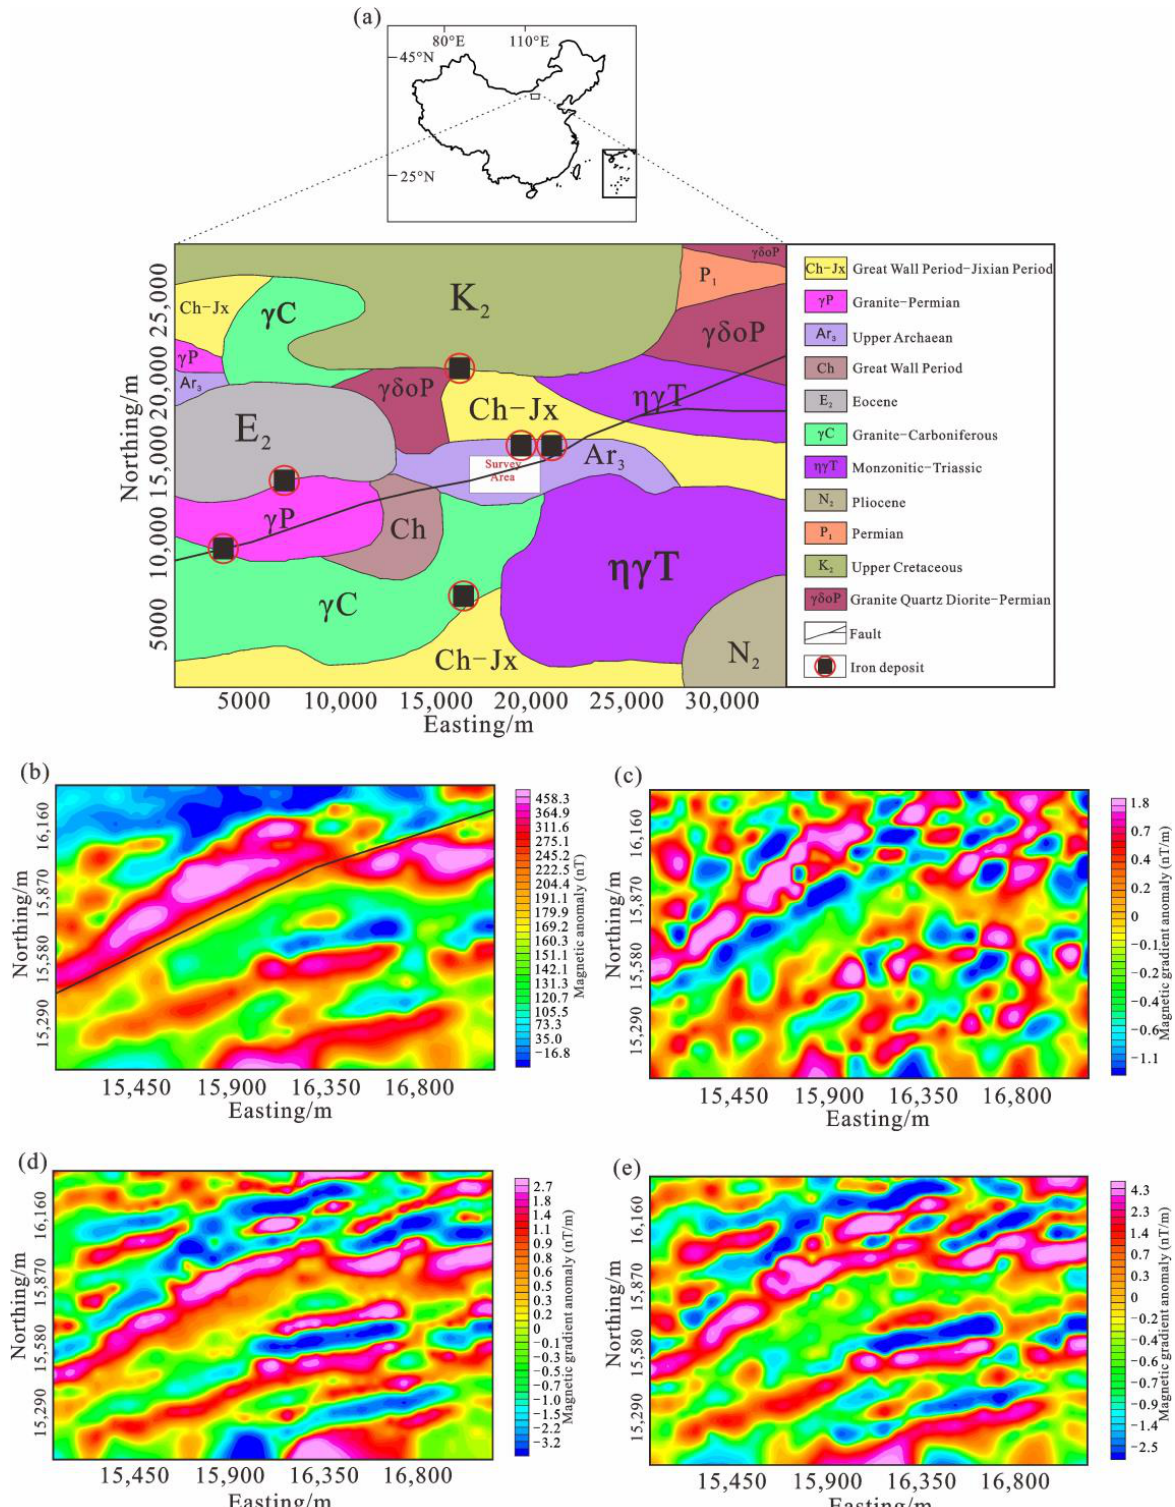
Figure 11. Geographical location and geological conditions and the measured aeromagnetic and gradient anomalies. ( a ) Geographical location and geological conditions of the survey area. ( b ) Measured aeromagnetic anomaly. ( c ) Measured aeromagnetic gradient anomaly in the x – direction. ( d ) Measured aeromagnetic gradient anomaly in the y – direction. ( e ) Measured aeromagnetic gradient anomaly in the z – direction.